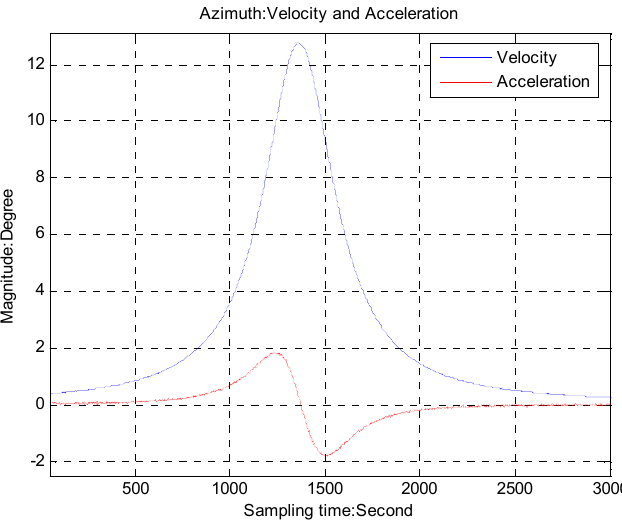
Figure 7. The simulative target velocity and acceleration.